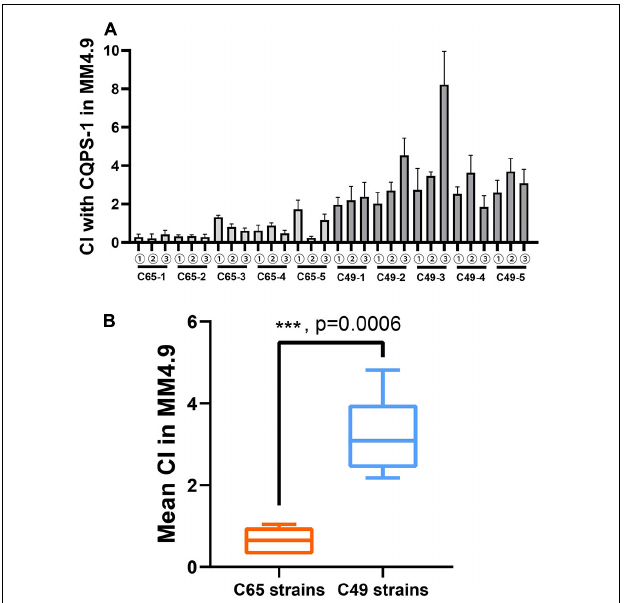
FIGURE 4 | Competitive index (CI) values of experimental strains relative to the ancestral clone CQPS-1 growing in MM medium with pH 4.9 by distinguishing colony morphology. The CI was defined as the experimental/ancestral-clone ratio divided by the ratio in the corresponding inoculum. (A) Individual CI value of selected clones. (cid:192) - (cid:194) means three clones randomly isolated from each independent population generated by a long-term serial passage experiment from the control environment or the acidic environment. (B) Comparison of the mean CI of all selected clones from C49 strains and C65 strains. Asterisks indicate statistical significance (unpaired t -test).